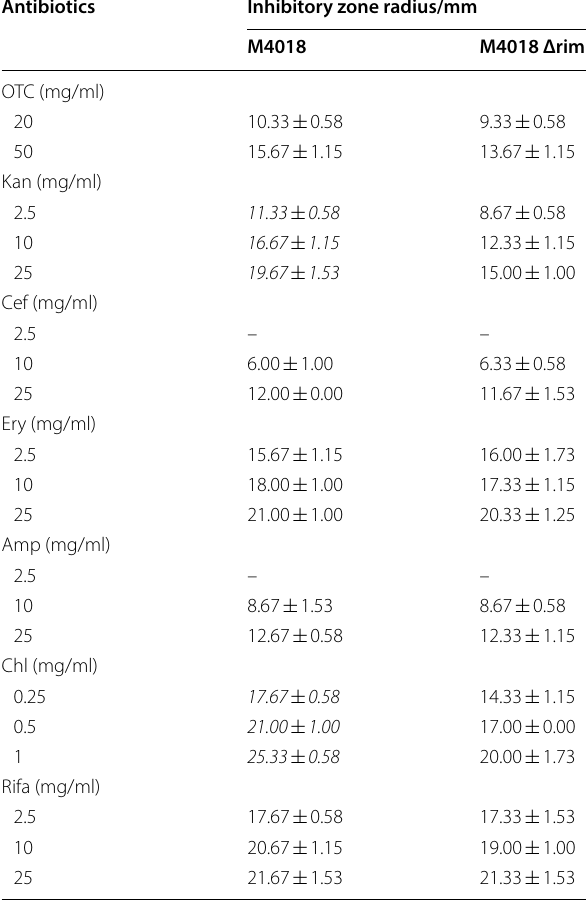
Numbers in italic represent significant increase in radius of inhibitory zone under the same experimental conditions. M4018: the parental strain, M4018 Δrim: the rimA1 -disrupted mutant derived from M4018; the antibiotics used in the study include oxytetracycline (OTC), kanamycin (Kan), cefotaxime (Cef), erythromycin (Ery), ampicillin (Amp), chloramphenicol (Chl) and rifamycin